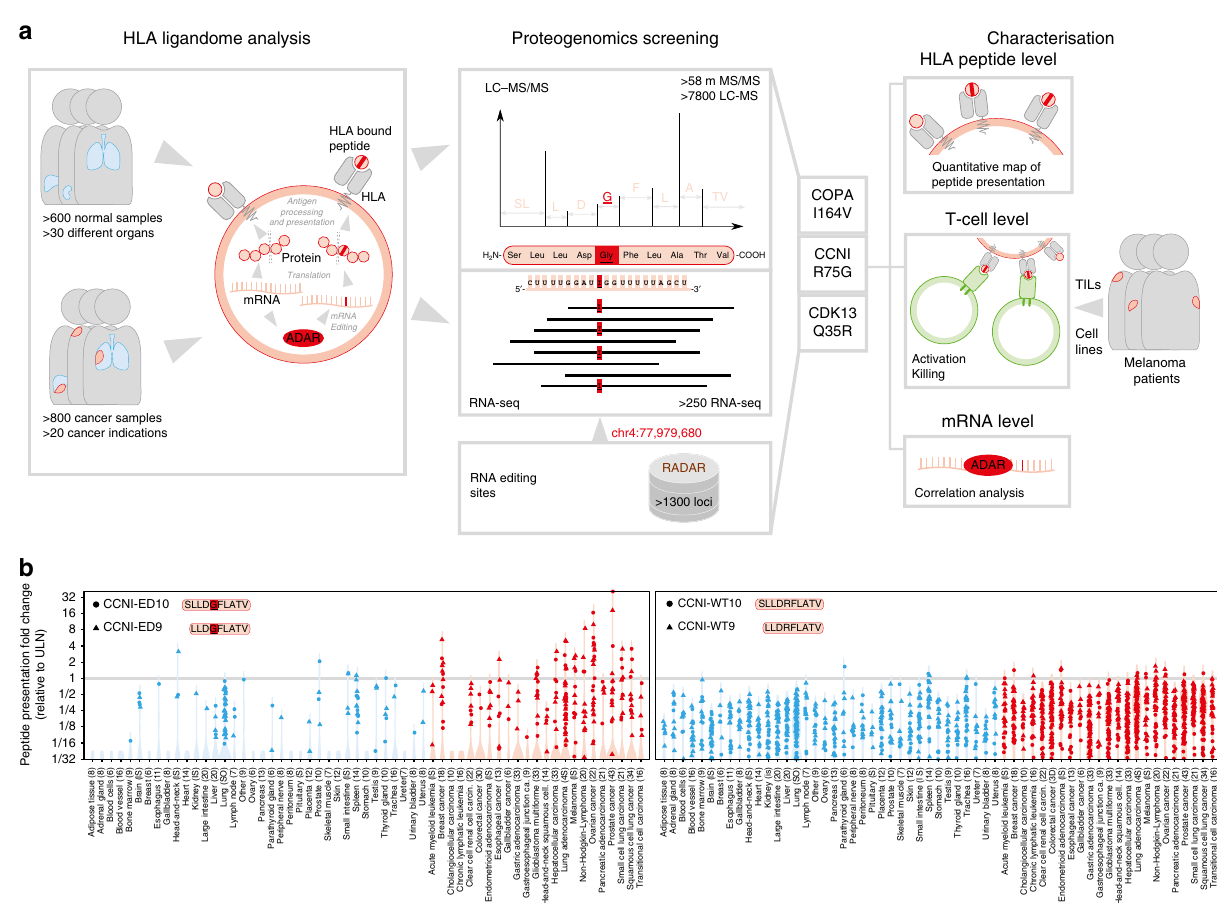
Fig. 1 Discovery of RNA editing derived HLA peptides and MS-based quantitation of edited peptides from CCNI. a Pipeline combining RNA-seq and LC – MS data from primary tissue for discovery of HLA ligands derived from RNA editing sites listed in RADAR. Edited nucleotides or amino acids are underlined and highlighted in red. CCNI peptides were quantitatively analysed and compiled into an in vivo map of peptide abundance to assess tumour association. In parallel, deeper target characterisation by assessment of immunogenicity and T cell killing was performed. For further validation, correlation between peptide and mRNA levels of edited CCNI and ADAR were assessed. b Relative abundance of HLA-bound peptides derived from edited and non-edited wild type (WT) CCNI peptides isolated from tumour (red) and normal samples (blue). Each dot represents a sample for which the peptide was detected. Samples are grouped according to healthy organ or tumour indication. Total number of donors per group is indicated in parentheses. LC-MS signals were expressed as fold change relative to the upper limit of normal (ULN, grey line). Violin plots are superimposed to visualise the distribution of all samples including those with low (<1/32 ULN) or without peptide